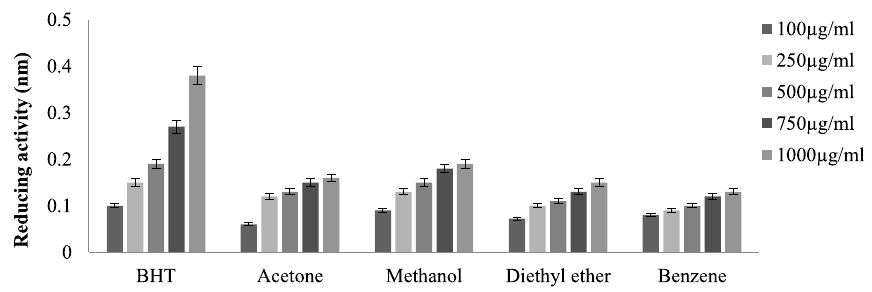
Fig. 9 Ferric reducing activity of P. dendritica